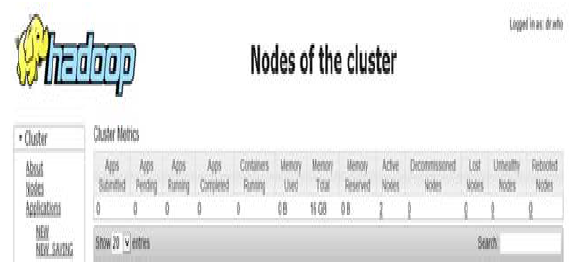
Figure 5 . Web view of hadoop multinode cluster